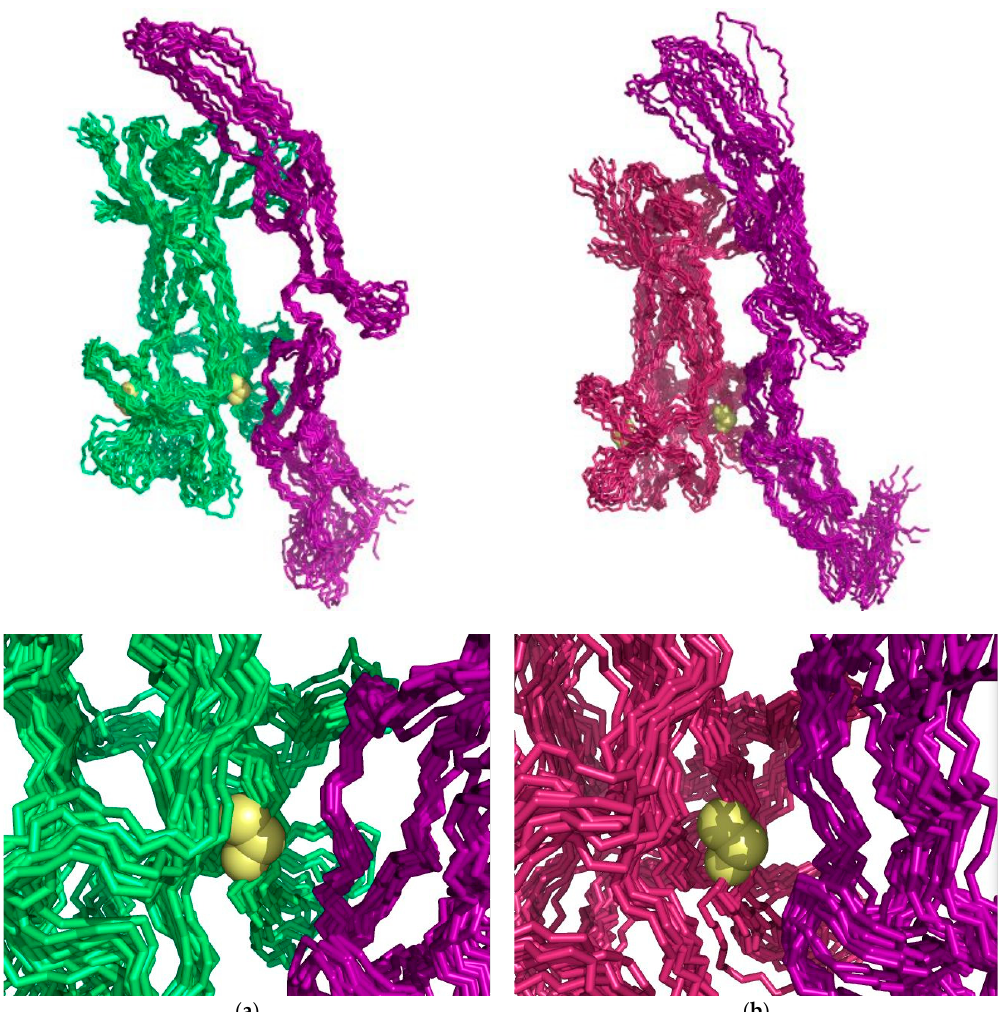
Figure 11. The structural ensembles generated by MD simulations for the complexes of p75NTR (in purple) with ( a ) NGF WT (in green) and ( b ) NGF R100W (in magenta). The bundle of 10 most populated poses along the 100 ns simulation window for the overall complexes ( upper panel) and the detail of the contact surface involving position 100 ( lower panel), whose backbone atoms are highlighted by yellow spheres, are shown. Figure produced by Pymol (Schrödinger LLC 2010).